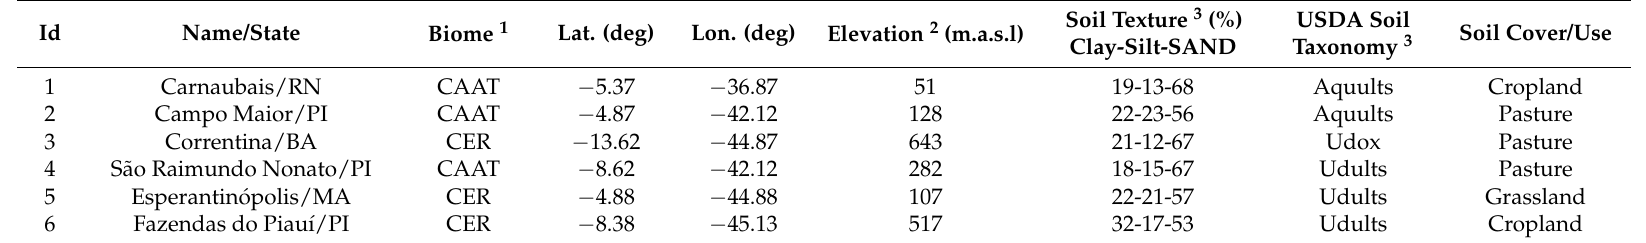
Table 1. Geographical and other information of benchmark